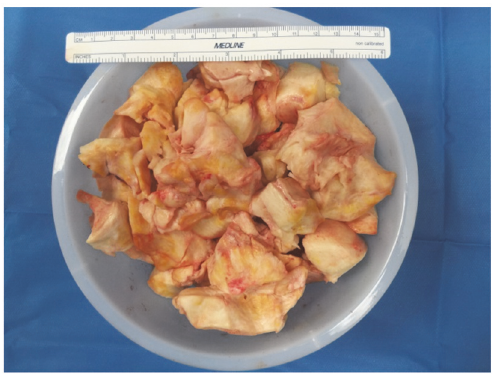
bleeding, we performed a right salpingo-oophorectomy. This procedure was done via laparoscopy and